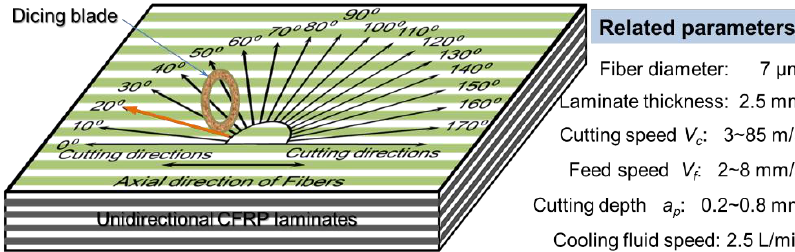
Figure 4. Schematic diagram of cutting direction and cutting parameters.